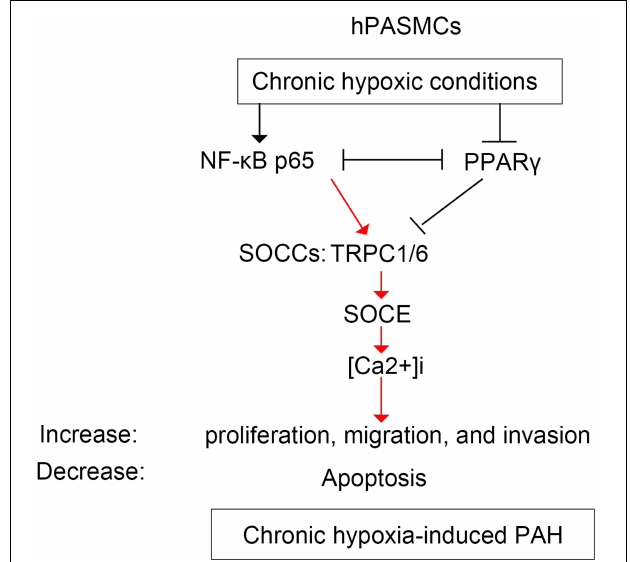
FIGURE 10 | The schematic diagram illustrating the regulation of p65 and PPAR γ on TRPC6-mediated SOCE and PAH. hPASMCs, human pulmonary arterial smooth muscle cells; PAH, pulmonary artery hypertension; SOCE, store-operated calcium entry; TRPC, transient receptor potential